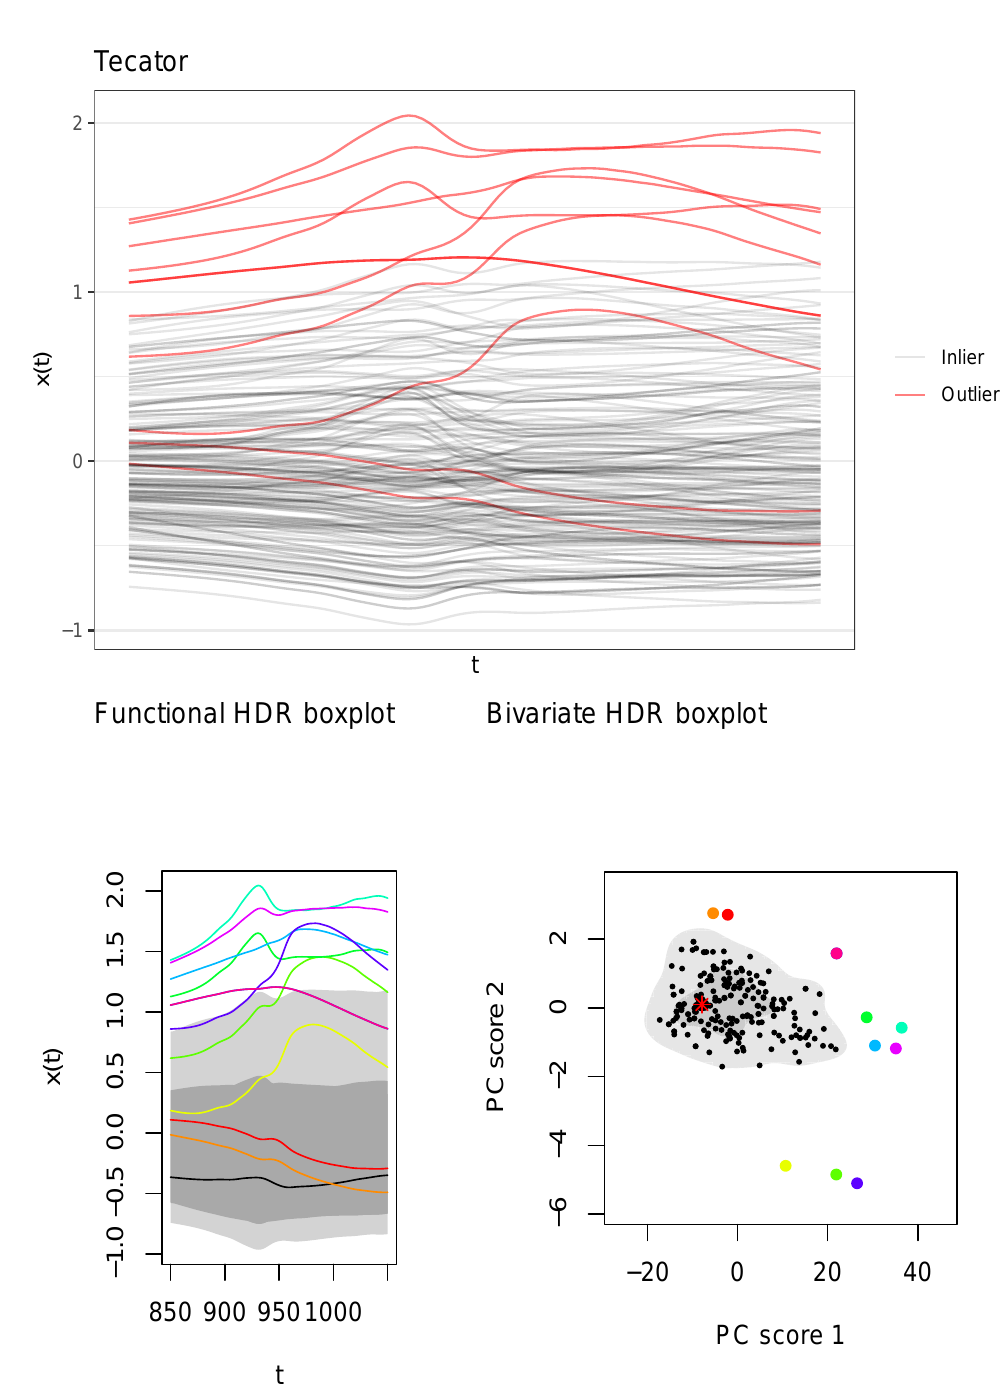
Figure A12. Upper row: Tecator data. Lower row, left column: functional HDR boxplot; right column: bivariate HDR boxplot. Colored curves/points are outliers according to a coverage probability of 0.05 for the functional HDR boxplot. HDR boxplots computed with rainbow::fboxplot